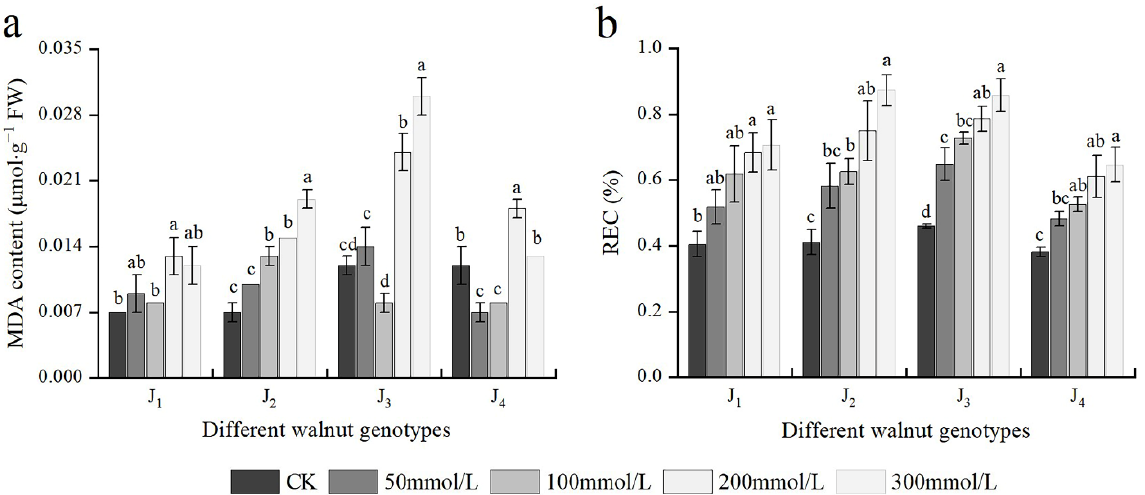
Figure 5. Effect of salt stress on ( a ) the malondialdehyde (MDA) content, ( b ) relative electrical con- ductivity (REC) of walnut. Four walnut genotypes were grown under different NaCl concentrations (0, 50, 100, 200, and 300 mmol/L) for 28 d. Each value indicates the mean ± standard error (SE) of three biological replicates. Bars of each parameter labeled with different letters are significantly different ( p < 0.05) by Duncan’s test.